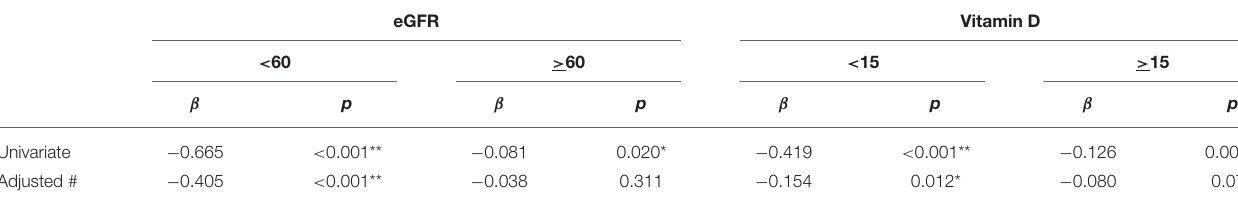
TABLE 3 | Correlations between eGFR and intact PTH in participants stratified according to eGFR and serum vitamin D concentration. eGFR